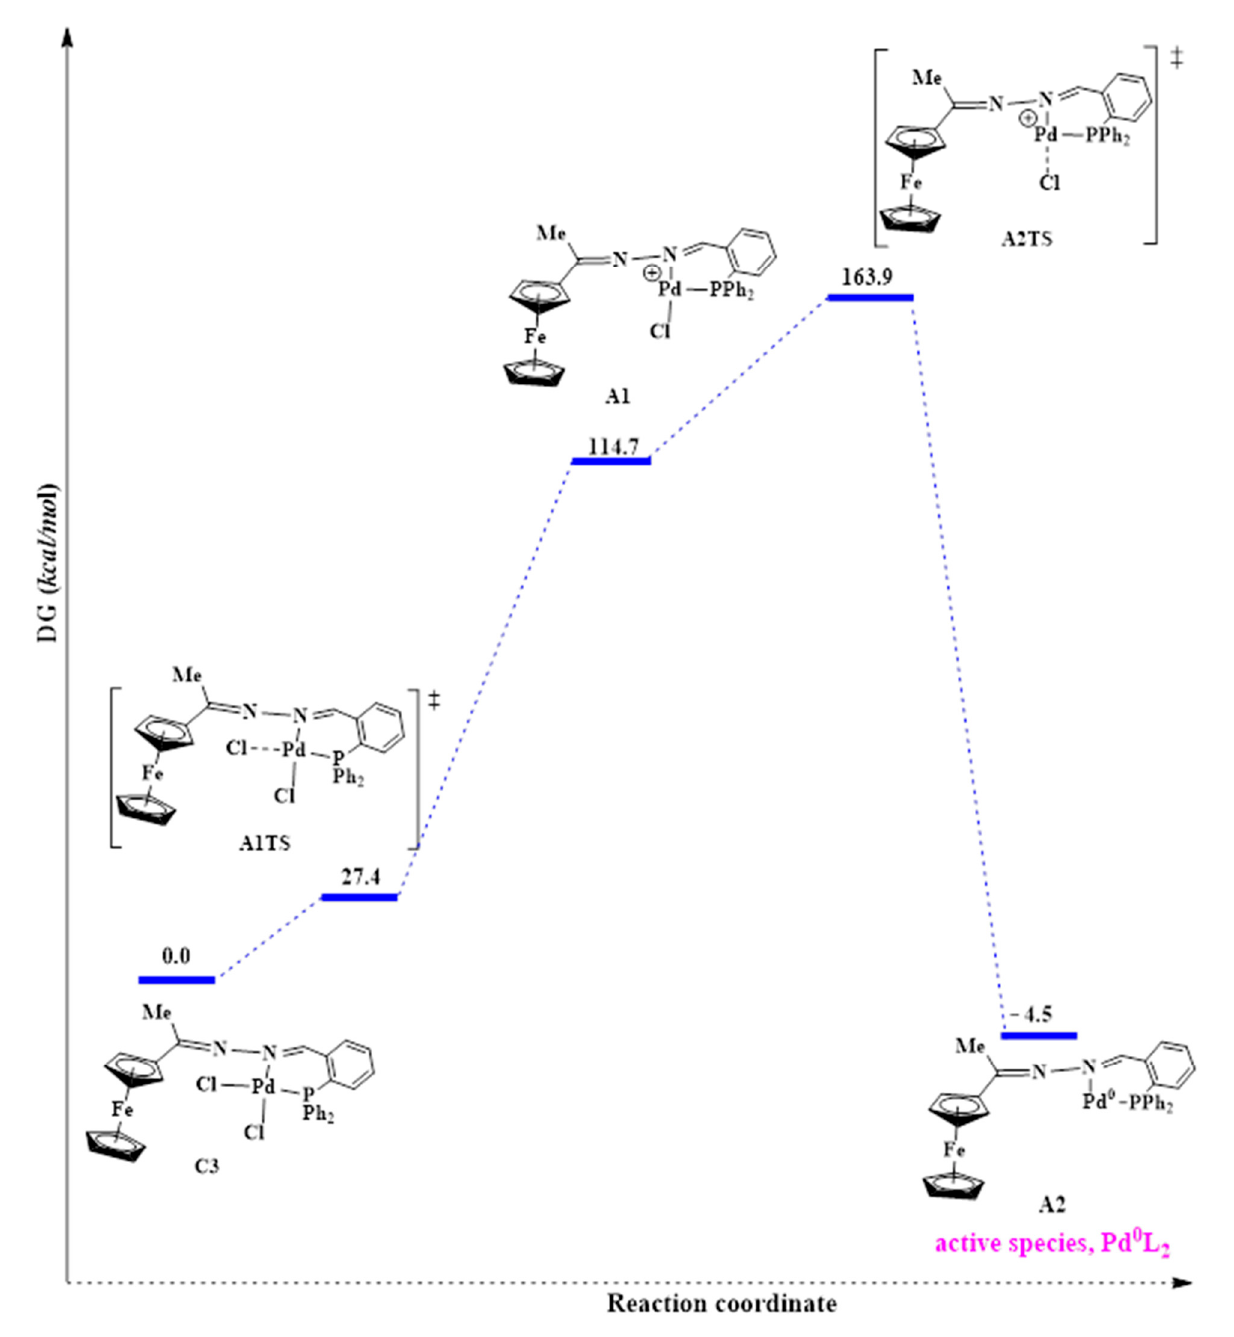
Figure 17. Reaction profile for the proposed pathway leading to the active Pd 0 L 2 species. However, this was followed by formation of a very unstable intermediate ( A1 ) with an energy of 114.7 kcal/mol. The high energy demand (87.3 kcal/mol) for forming this intermediate is possibly why high temperatures (of 110 °C and above) were required, experimentally, to activate this pre ‐ catalyst C3 during the catalytic testing. The second Pd ‐ Cl bond cleavage had a transition state, A2TS, with an even higher energy of 163.9 kcal/mol and was achieved after overcoming an energy barrier of 49.2 kcal/mol. The high energy demands for A1 and A2TS showed that these are extremely unstable and would be difficult to isolate experimentally. Also, since we have seen that the solvent plays a role in stabilizing the active species, the absence of the solvent in the model (calculations conducted in vacuum) means that A1 and A2TS are not solvents stabilized here, and